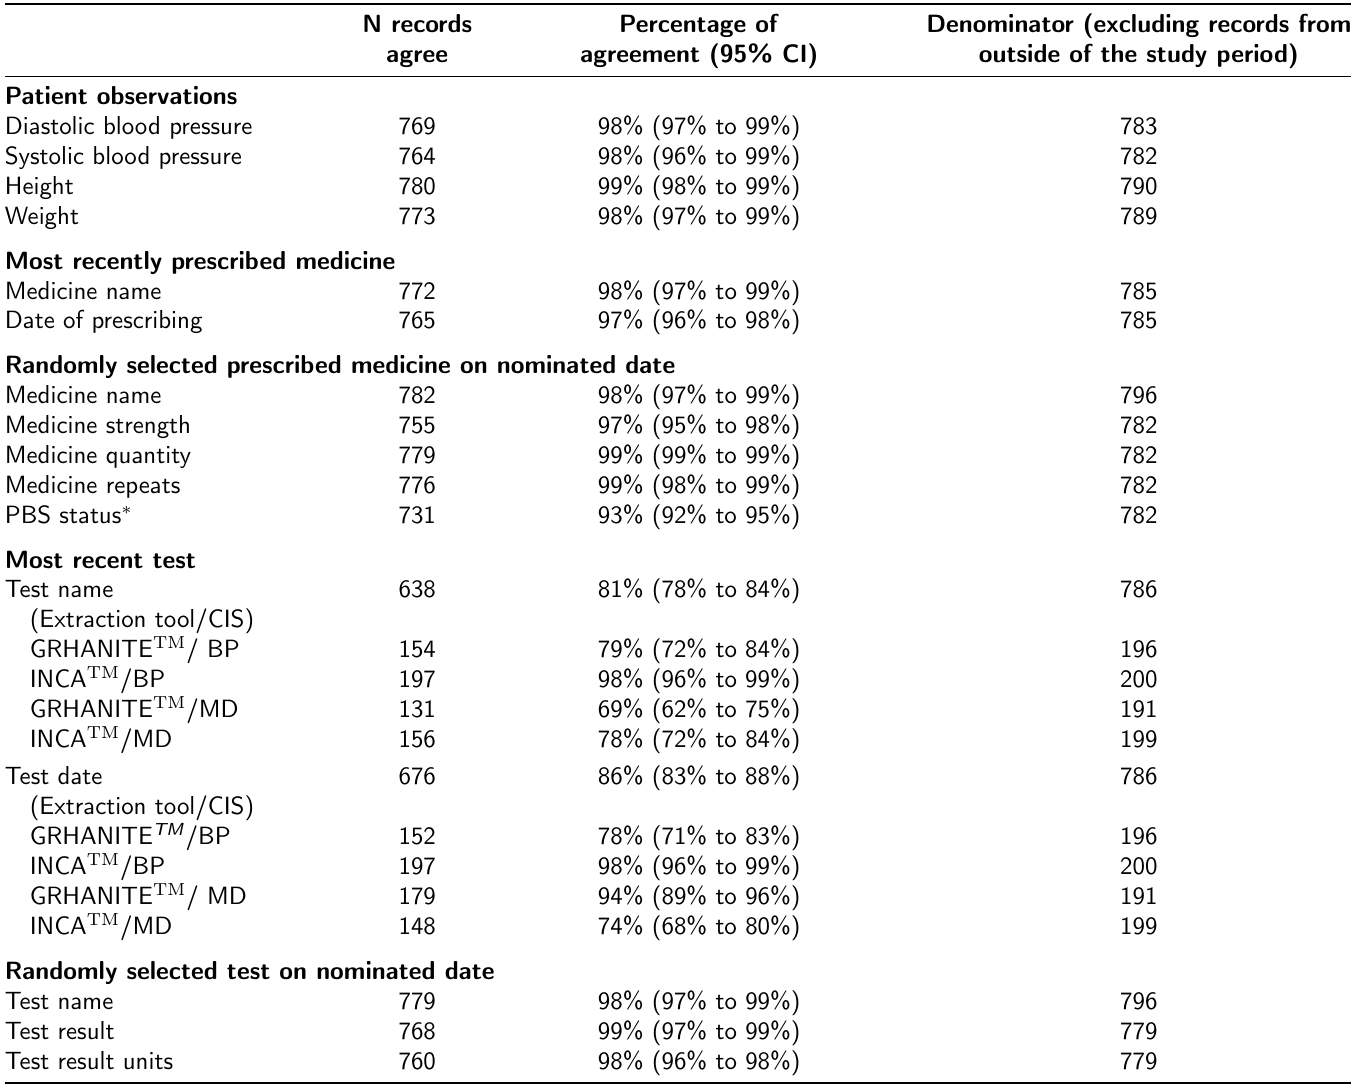
Table 1: Agreement between MedicineInsight and EHR data fields for patient observations, prescribed medicines, and tests